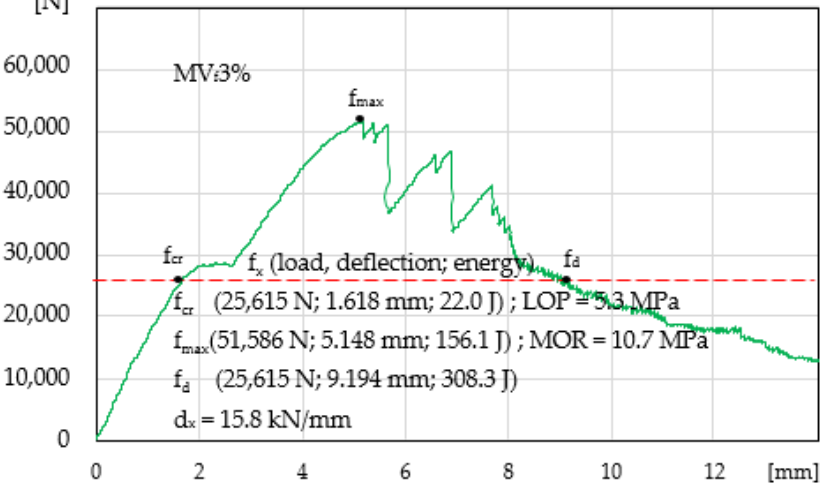
Figure 6. Load-deflection curve in the four-point bending test, mortar MV f 3%.